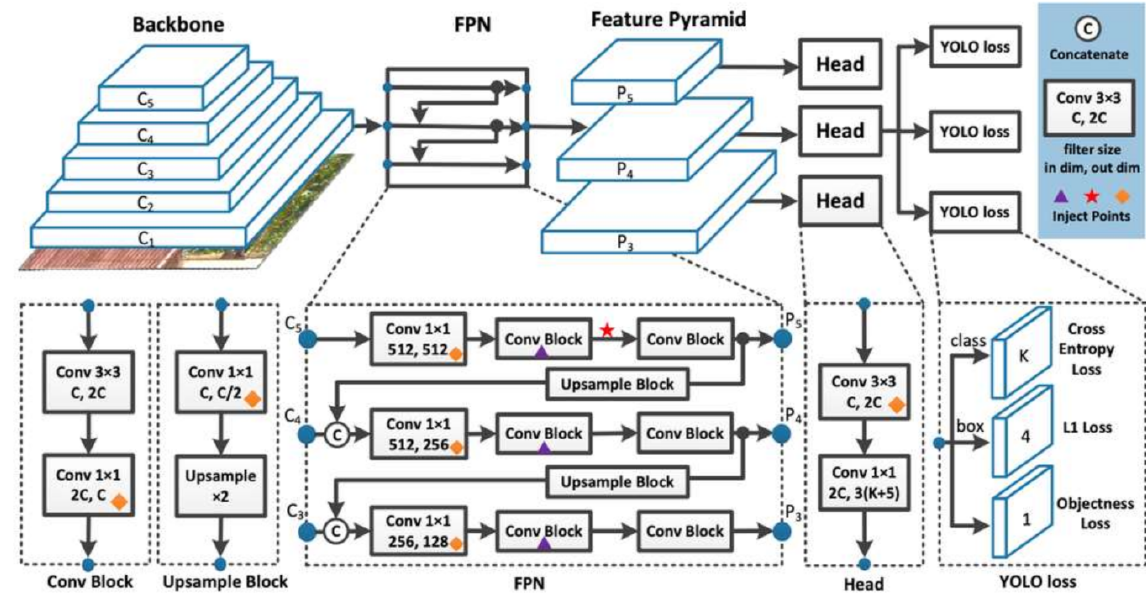
Figure 3. YOLOv7 network architecture